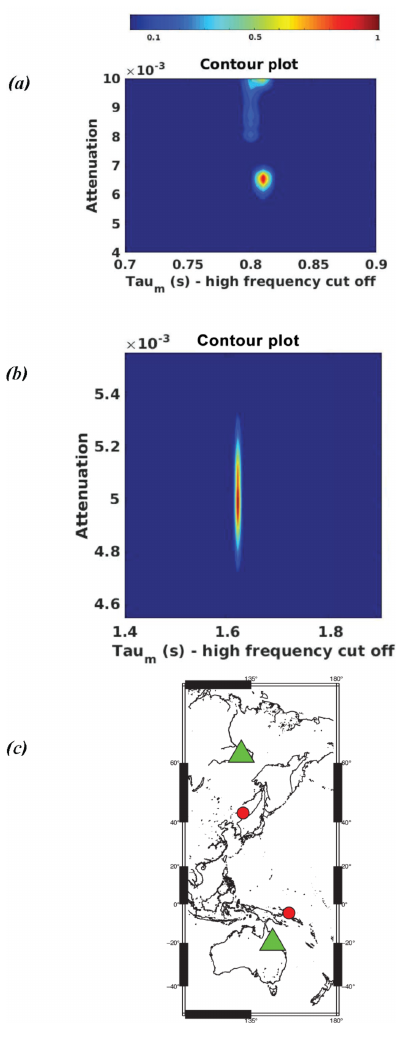
Figure 7. Contour plots of probability density functions obtained with multiple ScS observations in two regions. Event (circles) and station IU (triangles) locations for the two regions described be- low are shown in panel (c) . (a) Mantle beneath Papua New Guinea region: observations are recorded by station CTAO (20.08 ◦ S, 146.25 ◦ E) for a 490km deep, M w 6.6 event (4.543 ◦ S, 154.88 ◦ E) which occurred on 2 May 1998, 13:34:28UTC. Event–station dis- tance is 17.6 ◦ . (b) Mantle beneath the eastern China–Russia bor- der region: observations are recorded by station YAK (62.03 ◦ N, 129.68 ◦ E) for a 568km deep, M w 7.3 event (43.76 ◦ N, 130.66 ◦ E) which occurred on 28 June 2002, 17:19:30UTC. Event–station dis- tance is 18.3 ◦